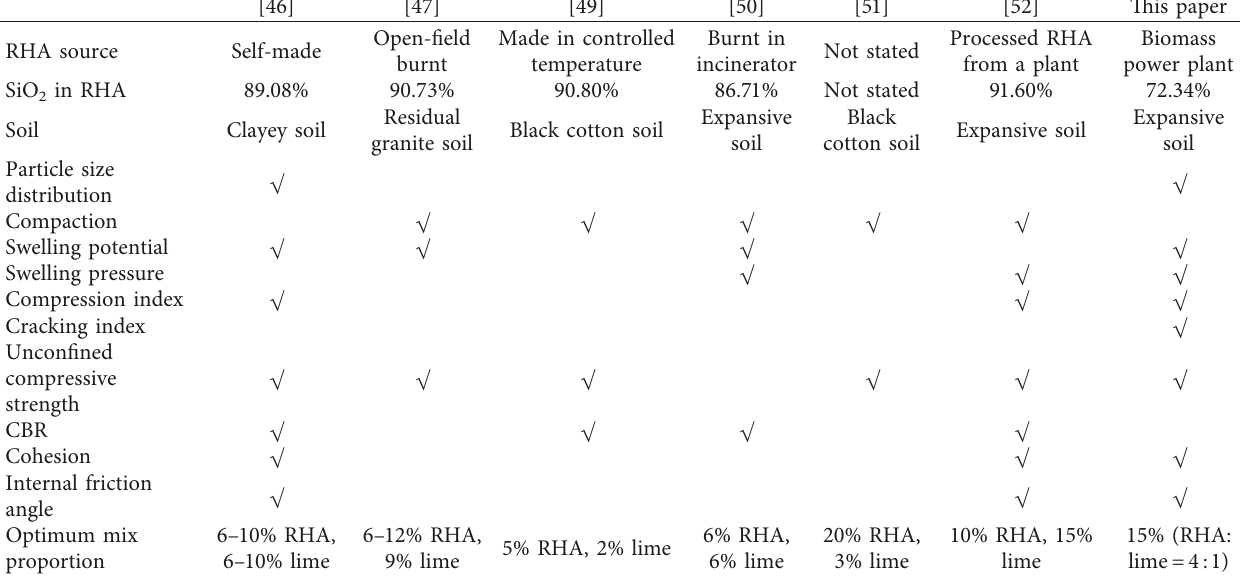
Table 8: Result comparison with existing